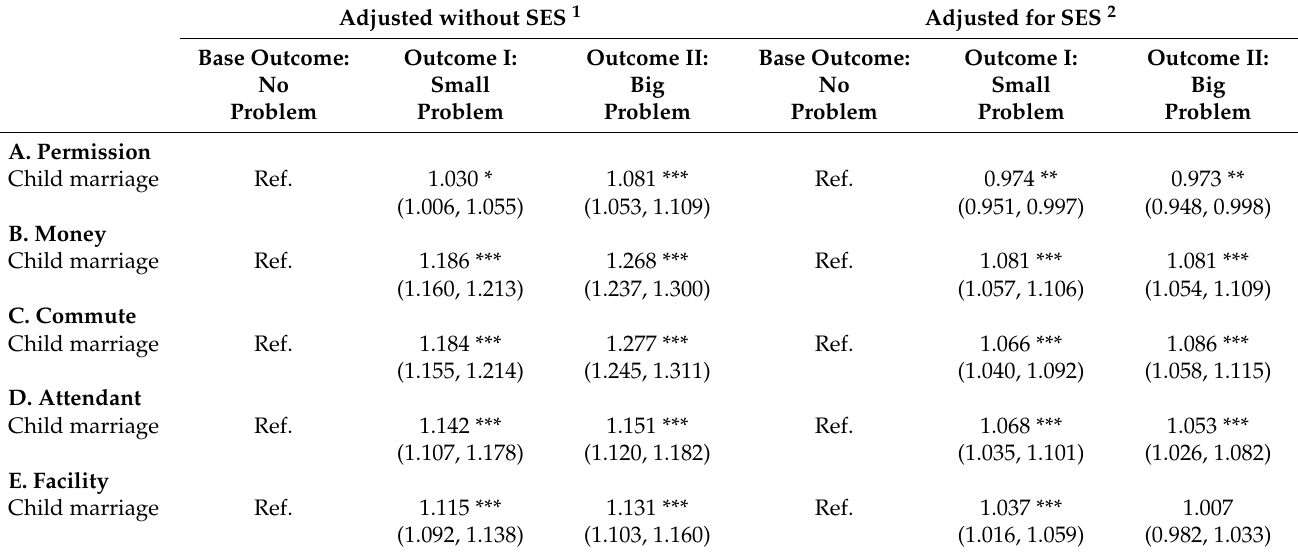
Table 3. Estimates of adjusted relative risk ratios for facing specific problems accessing